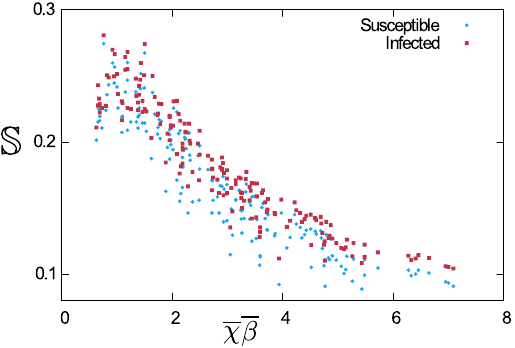
Figure 6. Sharpness of the power spectra as a function of the product of the mean susceptibilities and infectivities at birth/infection. Data is for the populations described in Fig.